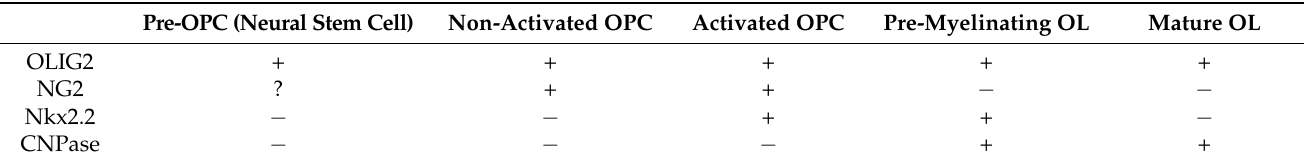
Table 1. Molecular markers of